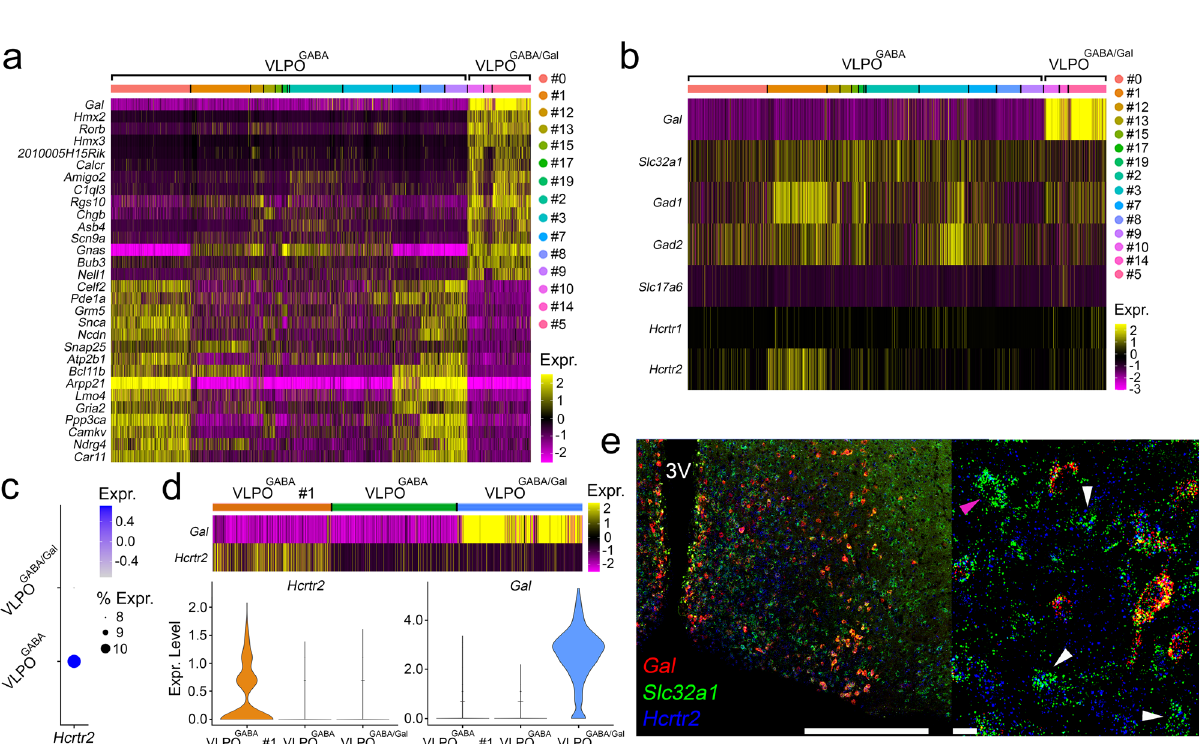
Fig. 5 Differential expression pro fi les and orexin receptor expression in VLPO GABA/Gal and VLPO GABA neurons. Heat maps representing the expression levels of the top 30 differentially expressed genes ranked by adj-p (panel a ; top 15 hypo- and top 15 hyper-expressed) and expression levels of GABAergic genes ( Slc32a1 , Gad1 , Gad2 ), Hcrtr1, Hcrtr2 , Gal and Slc17a6 (panel b ) in the VLPO GABA (#0 – 3; 7 – 9; 12, 13, 15, 17, 19) and VLPO GABA/Gal (#5, 10, 14) clusters. Hcrtr2 positive neurons were largely restricted to VLPO GABA cluster #1. c Dot plot representing the average expression of Hcrtr2 gene ( x axis ) in VLPO GABA and VLPO GABA/Gal groups ( y axis ). Dot size: percentage of neurons that expresses a speci fi c gene ( bottom right ). Color intensity: expression level ( top right ). d Heat map of Gal and Hcrtr2 gene expression levels in VLPO GABA cluster #1 (orange; 489 neurons), in all the other VLPO GABA clusters (#0, 2, 3; 7 – 9; 12, 13, 15, 17, 19; green; down sampled to 515 neurons) and merged VLPO GABA/Gal clusters (#5, 10, 14; cyan; 515 neurons). Violin plots for Hcrtr2 ( bottom left ) and Gal ( bottom right ) differential gene expression: VLPO GABA cluster #1 (orange), all the other VLPO GABA clusters (#0, 2, 3; 7 – 9; 12, 13, 15, 17, 19; green) and VLPO GABA/Gal clusters (#5, 10, 14; cyan). Hcrtr2 is expressed in VLPO GABA #1 (VLPO GABA #1 vs VLPO GABA/Gal adj- p value = 4.98E − 32; VLPO GABA #1 vs. VLPO GABA (#0, 2, 3; 7 – 9; 12, 13, 15, 17, 19) adj- p value = 1.63E − 114). Gal is expressed in VLPO GABA/Gal neurons (VLPO GABA #1 vs VLPO GABA/Gal adj- p value = 1.26E − 144; VLPO GABA (#0, 2, 3; 7 – 9; 12, 13, 15, 17, 19) vs VLPO GABA/Gal adj- p value = 0). Heat map and Dot plot expression values are represented as z-scores. Expression levels is color- coded in the legend. In the heat maps, x-axis : individual clusters color-coded bar; y-axis : genes. As color dots: Cluster IDs ( right ). Test used: Wilcoxon Rank Sum two-sided Bonferroni-corrected Test. e Expression in VLPO of Gal (red), Slc32a1 (green) and Hcrtr2 (pseudo colored in blue) mRNAs. White arrows: Slc32a1 ( + ), Hcrtr2 ( + ) and Gal ( − ) neurons; magenta arrows: Slc32a1 ( + ), Hcrtr2 ( − ) and Gal ( − ) neurons. Scale bars: 500 and 20 µ m ( bottom right ). 3V, 3 rd ventricle. Source Data are provided as a Source Data fi le.